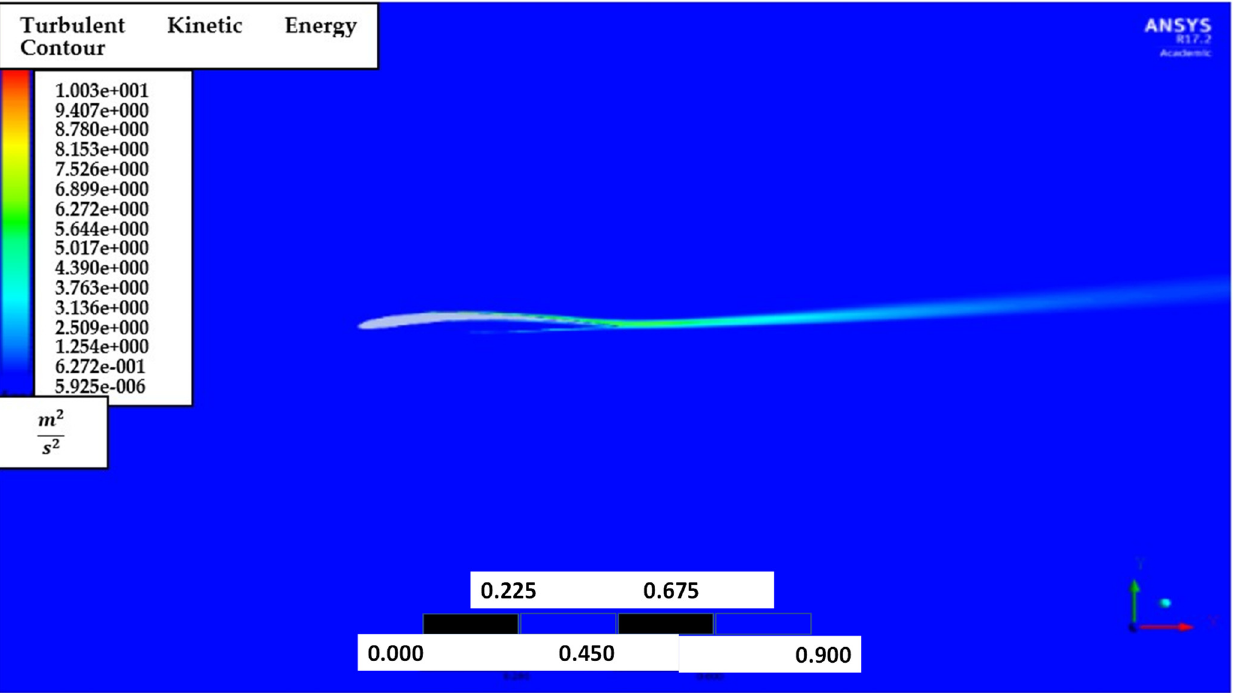
Figure 23. Turbulent kinetic energy contour of NACA2410 to 8410 transition at 5° AoA.